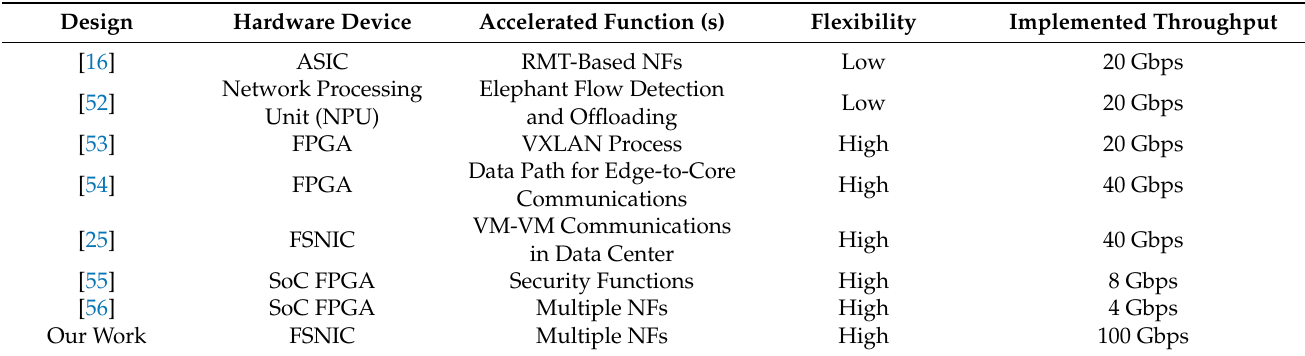
Table 6. Comparison to related